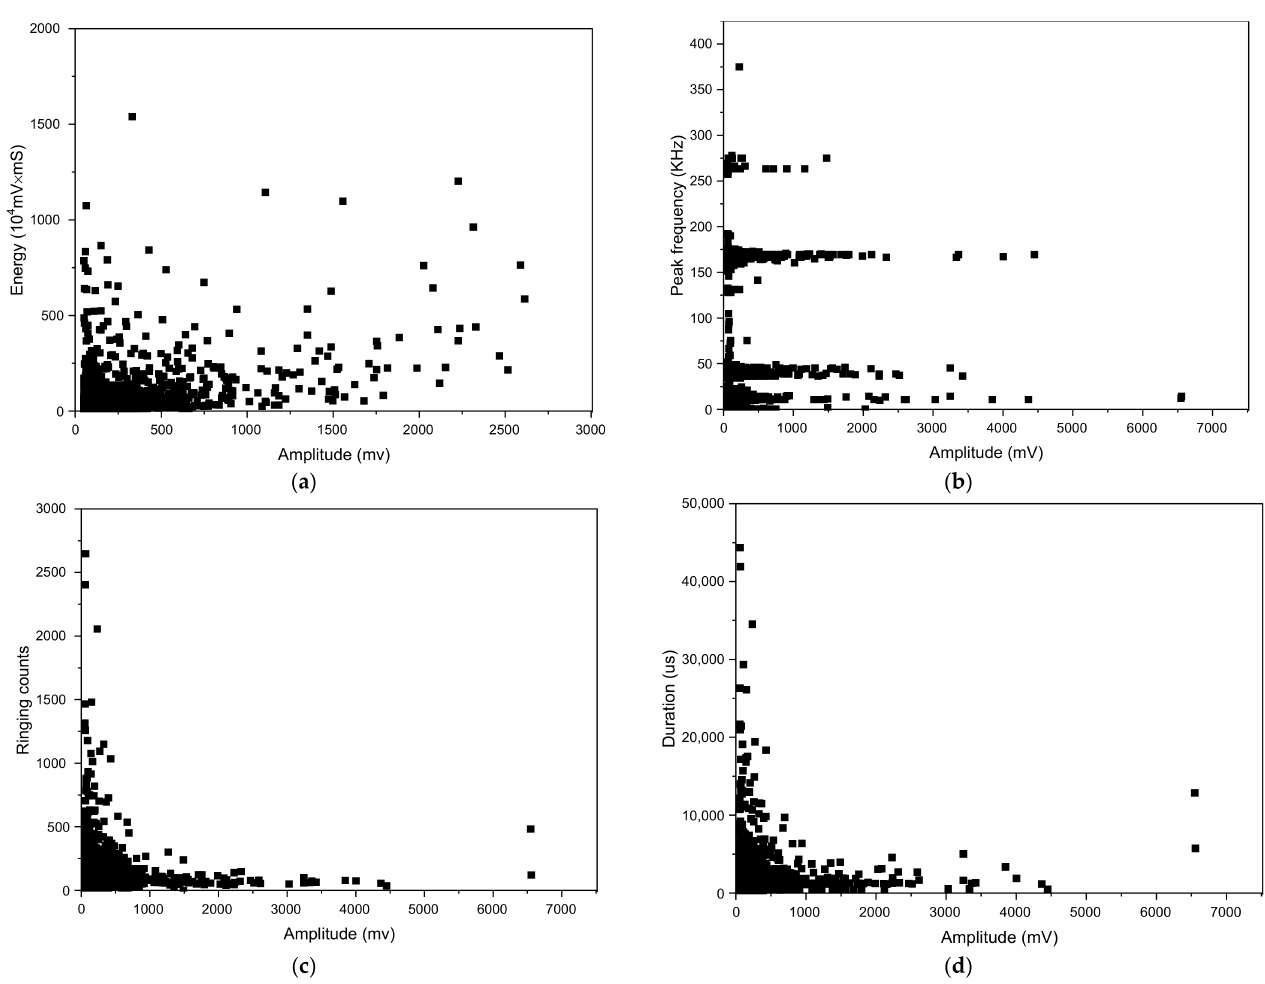
Figure 10. The acoustic emission signal correlations of the B-7-80% sample. ( a ) The total energy in terms of amplitude. ( b ) The frequency of the peak in terms of amplitude. ( c ) The ringing counts in terms of amplitude. ( d ) The duration in terms of